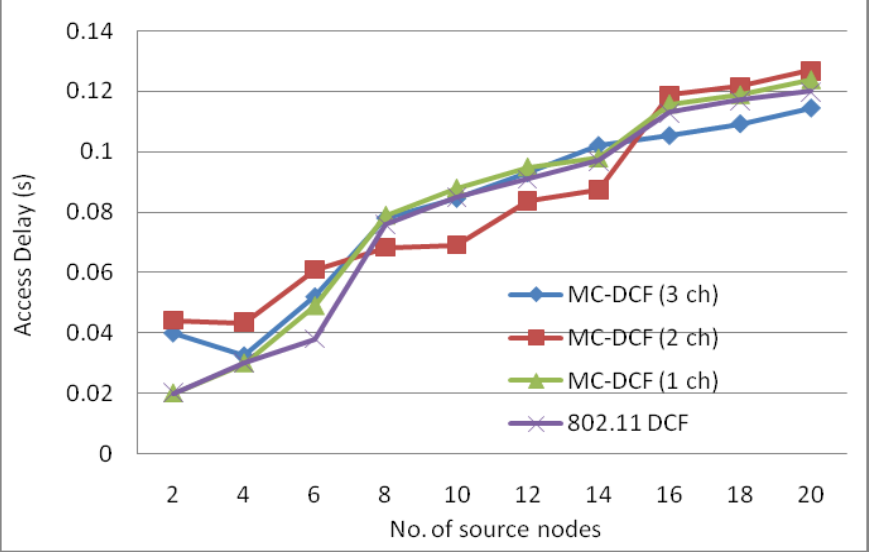
Figure 3. Delay impact from source nodes when using multiple sinks with single radio